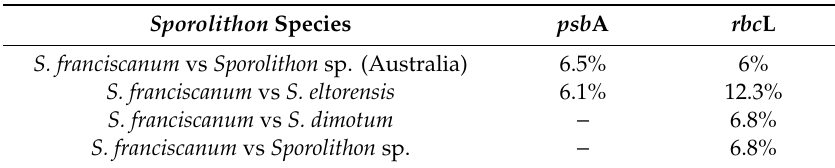
Table 1. Pairwise sequence divergence values (%) between S. franciscanum and other Sporolithon species from the new species phylogenetic